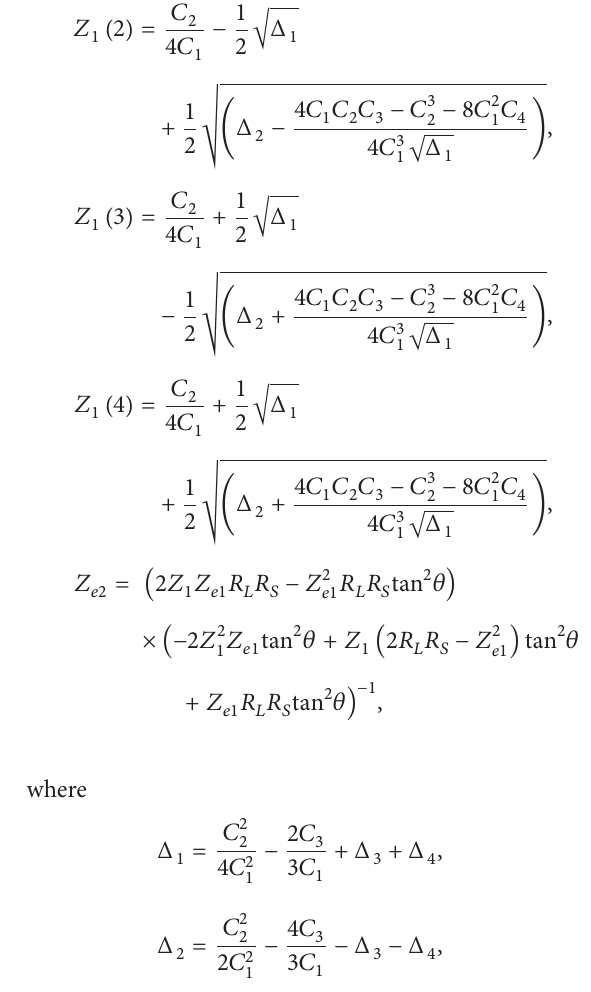
𝑍 𝑍 𝑅 𝑅 𝑍 𝑟 𝑒1 , 𝑜1 , 𝐿 , 𝑆 , 𝑆 , and